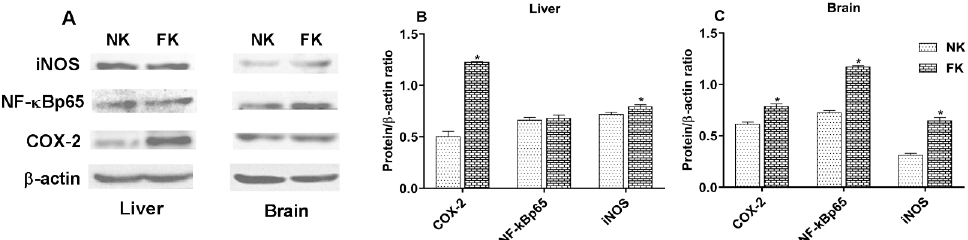
Figure 5. Protein bands of inflammatory factors and β -actin ( A ), and protein levels of COX-2, NF- κ Bp65, and iNOS in the livers ( B ) and brains ( C ) of laying hens with normal keel (NK) or fractured keel (FK). * p ≤ 0.05.